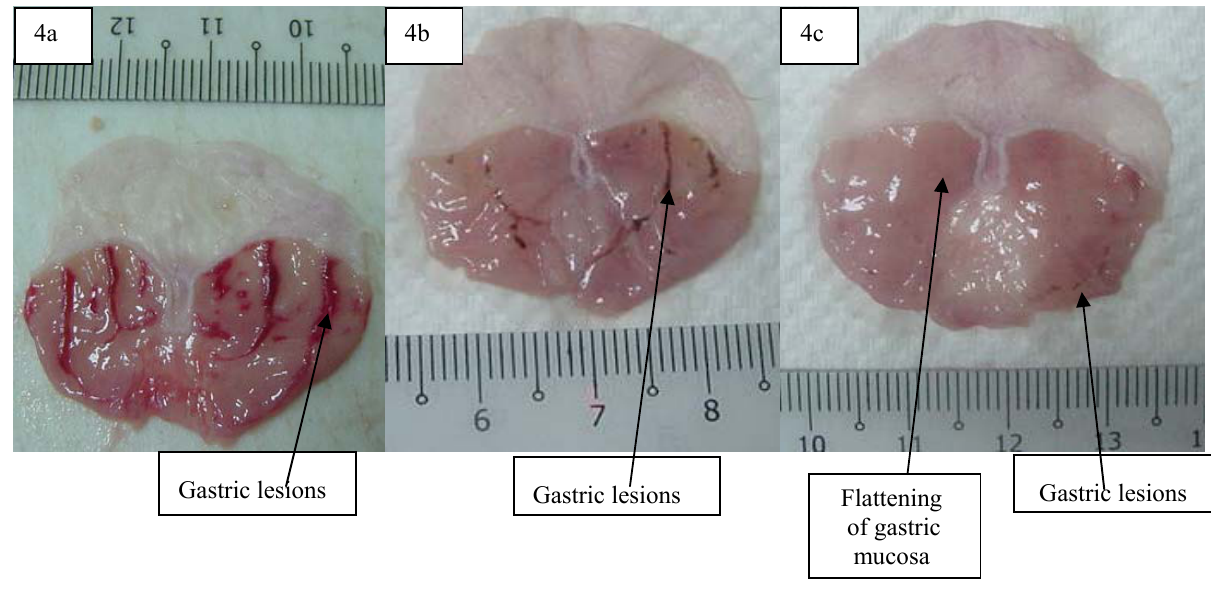
Figure 4. Gross appearance of the gastric mucosa in (4a) a rat pre-treated with distilled water (negative control). Severe injuries are seen (4b) in the gastric mucosa of a rat pre- treated with omeprazole (20 mg/kg). Injuries to the gastric mucosa are milder compared to the injuries seen in the negative control rat (4c) a rat pre-treated with 5 mg/kg of adiponectin. Mild injuries to the gastric mucosa are seen, and flattening of gastric mucosa is